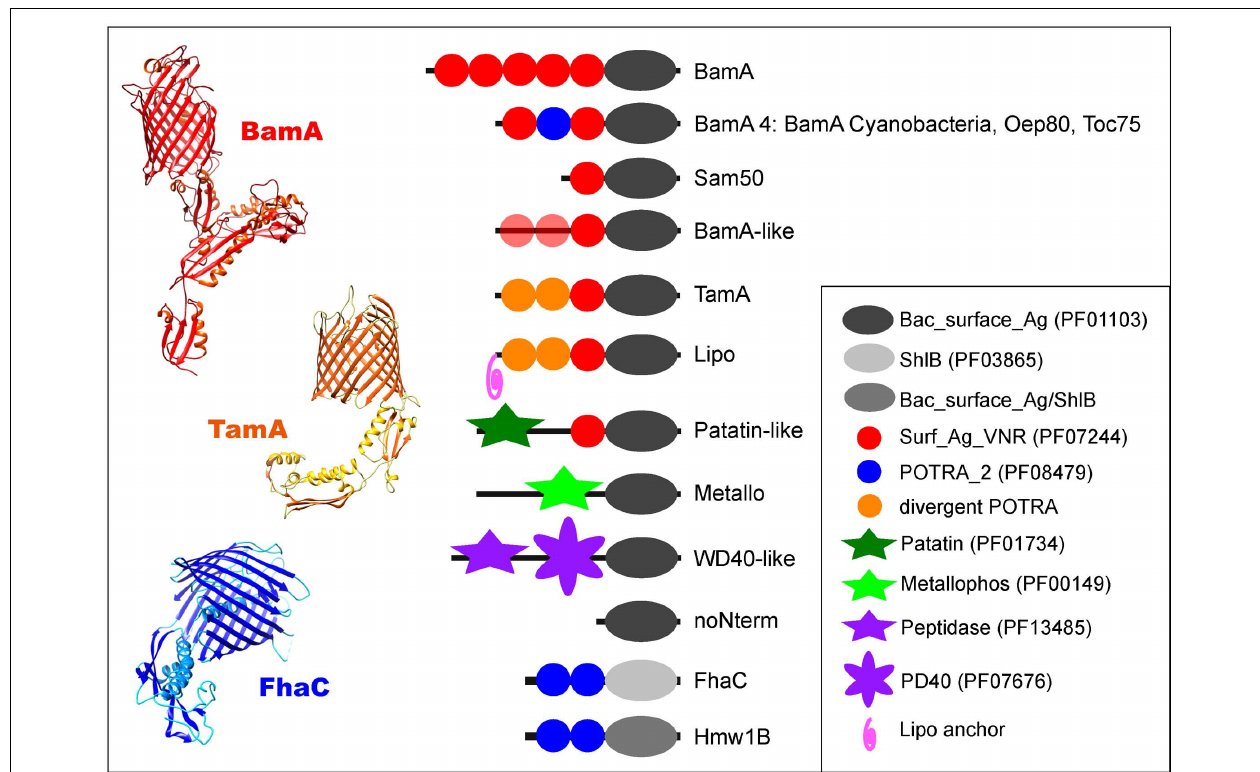
FIGURE 1 | Structural diversity of the Omp85/TpsB superfamily. Schematic representation of the domain architectures (detailed in Table S2 ) of the ten bacterial protein subfamilies that comprise the Omp85/TpsB superfamily, as well as the eukaryotic Sam50.The cyanobacterial BamA is shown as a separate group due to its exceptional domain architecture within